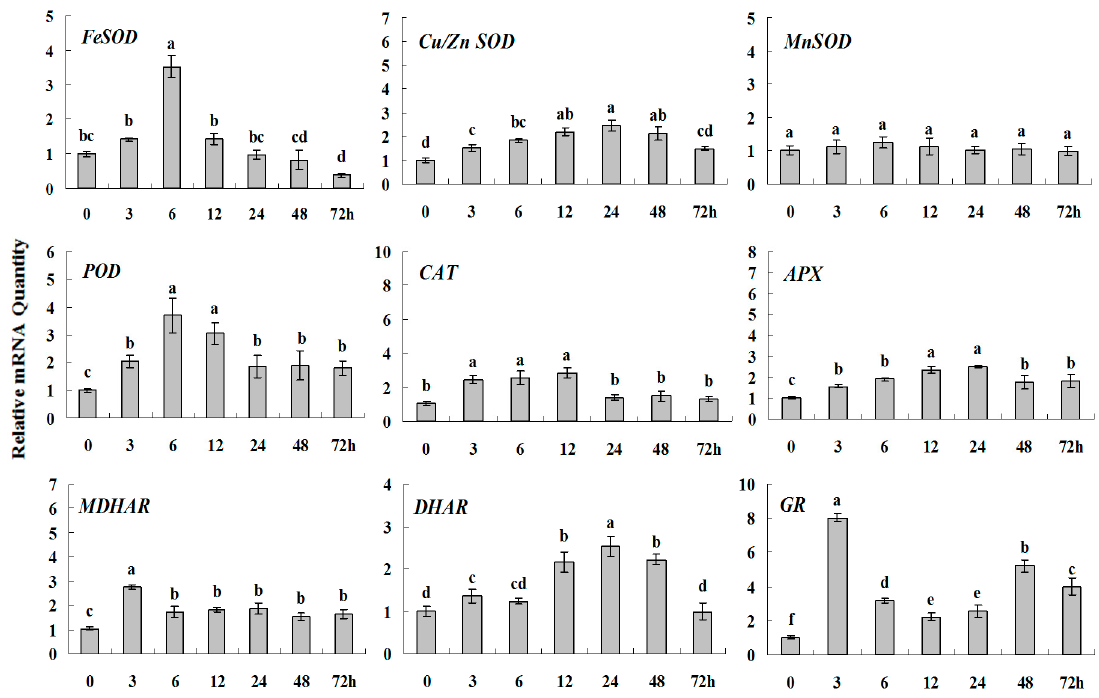
Figure 7. Quantitative real-time RT-PCR was used to analyze of ROS-scavenging enzyme genes expression treatment with ABA and normalized to β -actin . White clover leaves were sampled after 0, 3, 6, 12, 24, 48 and 72 h treatment. Data represent means of three replicates. Error bars representing standard errors and the different letters above the bars represent significant difference ( p < 0.05).